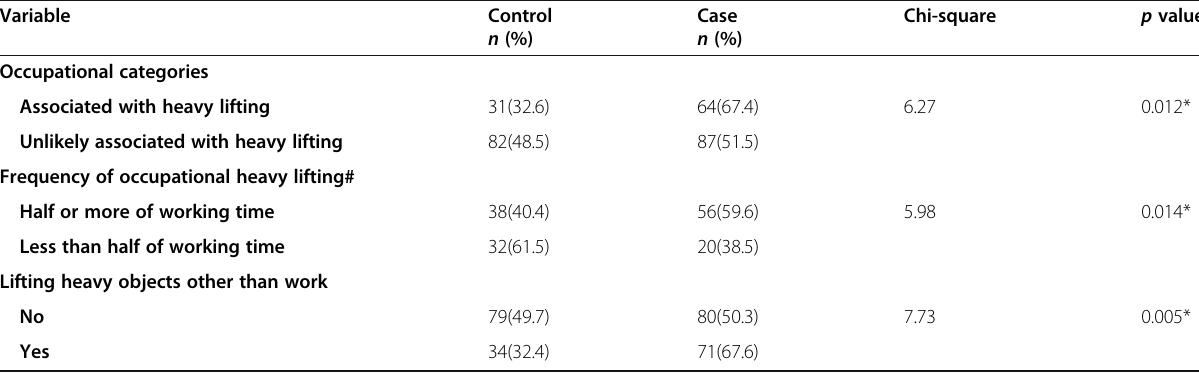
Table 3 Comparison between cases of retinal detachment and controls regarding heavy lifting and history of head trauma, Ain Shams Outpatient Ophthalmology clinic, Cairo, Egypt, 2018